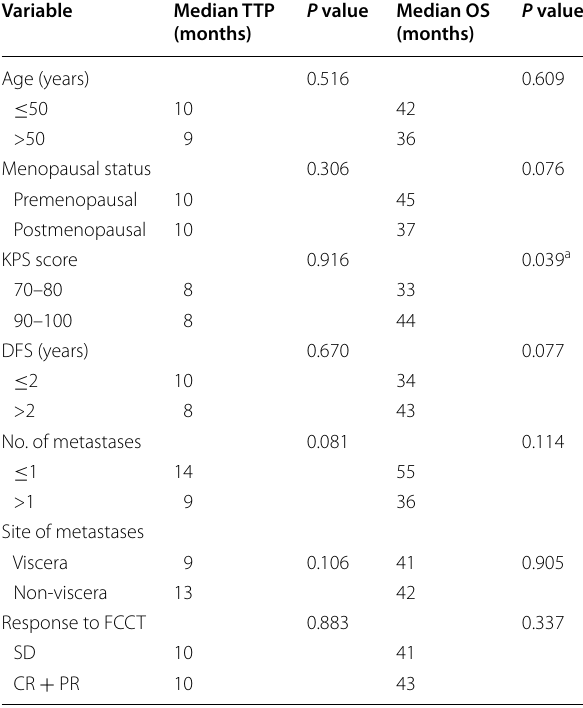
Table 2 Log-rank analysis of TTP and OS in the 138 patients who received maintenance therapy